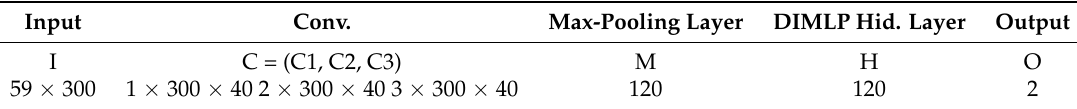
Table 2. Interpretable CNN architecture with symbols and